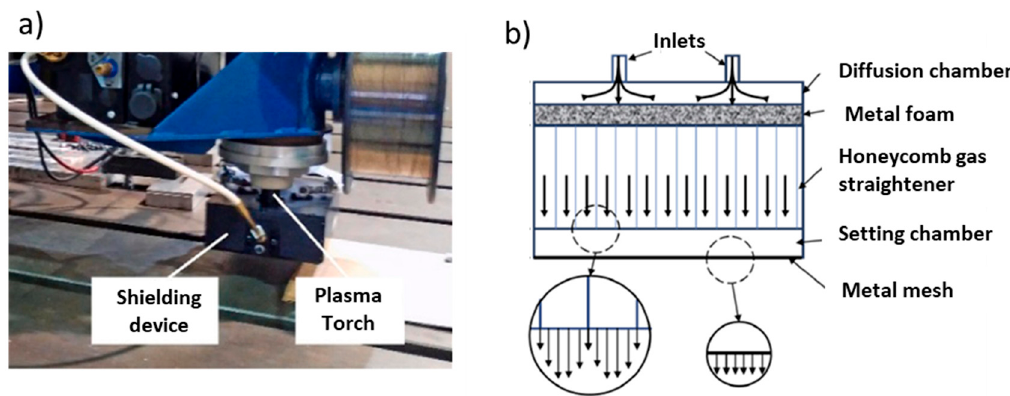
Figure 9. ( a ) Setup of the WAAM trailing shield device; ( b ) schematic representation of the shielding device (adapted from [39,41]).